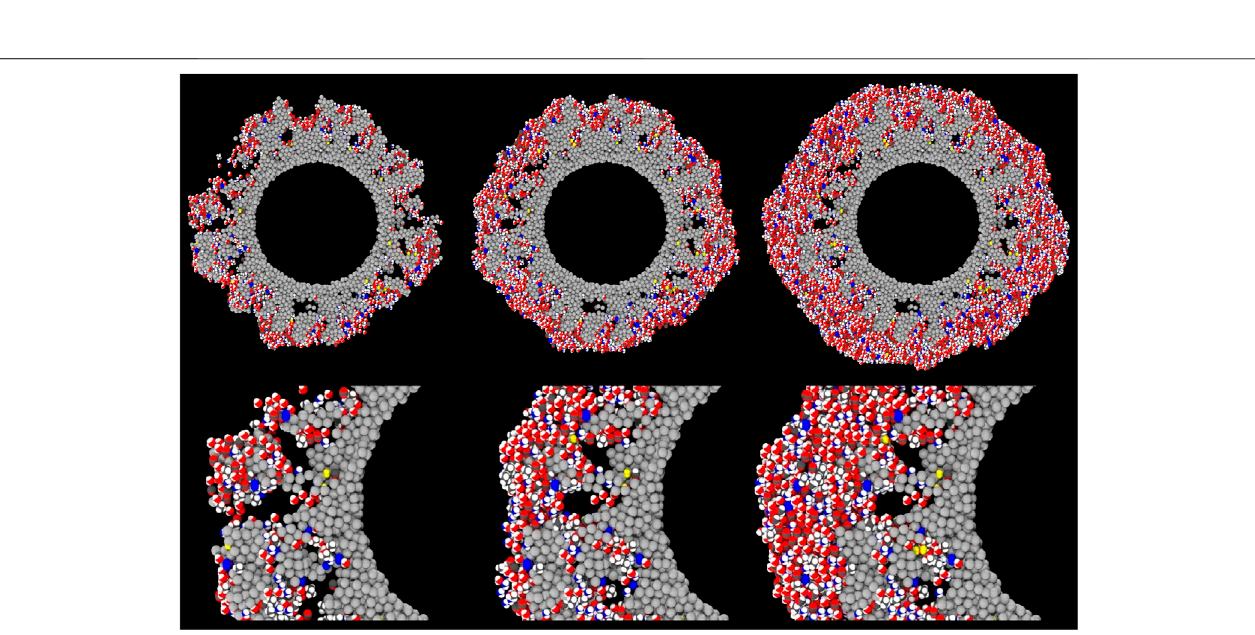
FIGURE3| Ray-traced,cross-sectionalimagesofthelarge(100 Åradius)porousgraintypeattheearlystagesoficebuild-up,correspondingtothegrainshownin the bottom row of Figure 2 ; here, the cross-section at a different angle is shown. Left to right: interval 25, interval 50, interval 100. The three upper panels show the full cross-section,whilethelowerpanelsshowclose-upimagesofthesamesmallregionofthegrainateachofthethreeintervals.Grayspheresrepresentthecarbonatoms composing the dust grain. Grain-surface atoms are represented by spheres of white (H), red (O), black (C) and blue (N). Molecules are similarly represented as collections of such atoms in appropriate structures. H 2 molecules are colored yellow for ease of identi fi cation.